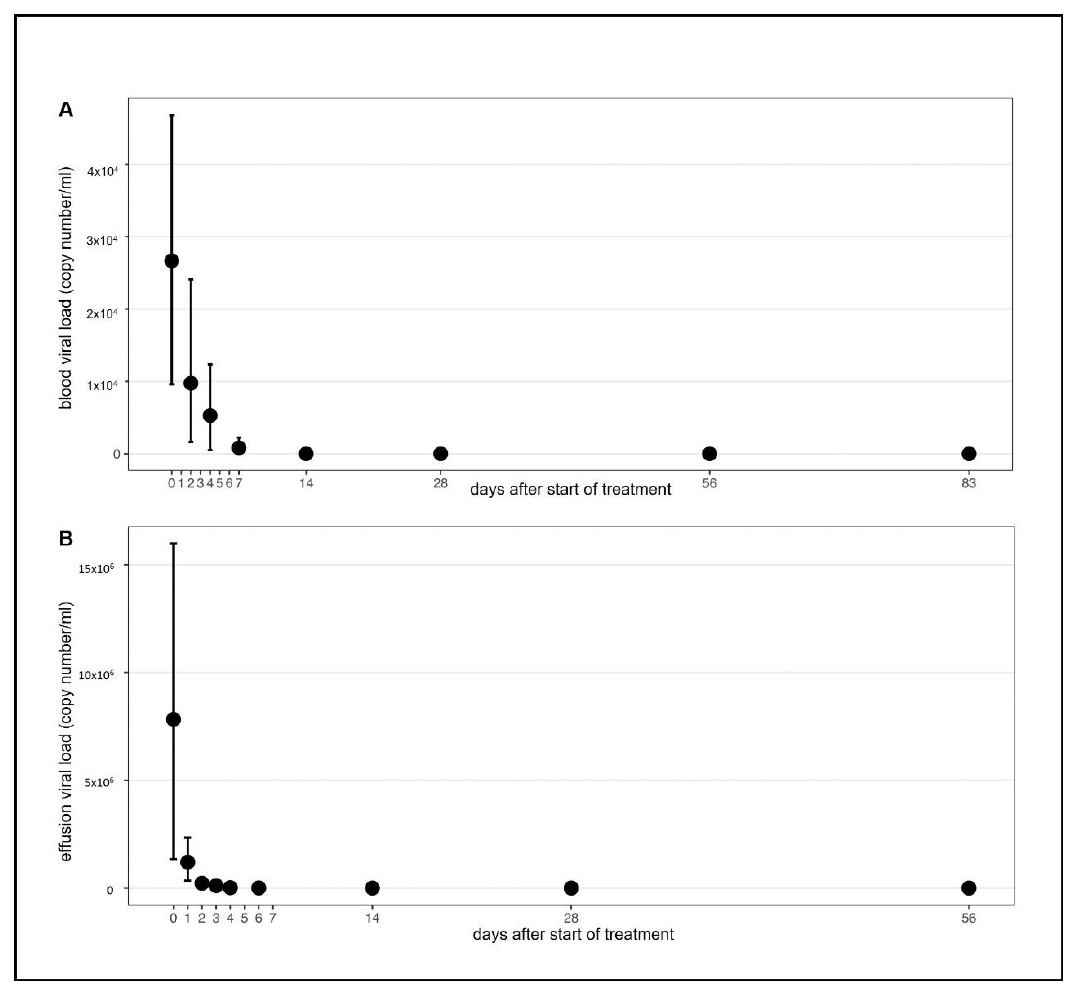
Figure 6 Figure 6. Viral load in blood and effusion throughout the study course. Figures show visualization of data using nonpara- Table 2. Adverse effects of the Xraphconn ® treatment, grades of adverse effects, day of first appearance, and respective symptomatic treatment. 1 Heinz body formation: mild (5–9.9% of red blood cells), moderate (10–25% of red blood cells), severe (>25% of red blood cells); 2 lymphocytosis: mild (4–7.9 × 10 9 /L), moderate (8–15 × 10 9 /L), severe (>15 × 10 9 /L)